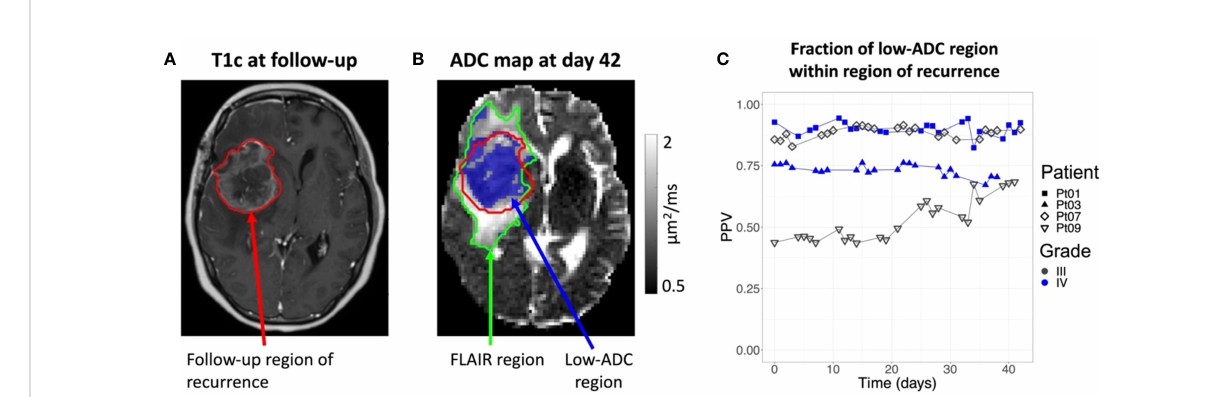
FIGURE 4 Overlap between intra-treatment low-ADC regions and recurrent tumor: (A) : The post-contrast T 1 -weighted image (T1c) of Patient 1 from a diagnostic scanner with the region of recurrence indicated by the red contour. Note that the recurrence region was taken as the enhancing tumor for the Grade 4 patients and the FLAIR hyperintensity for the Grade 3 patients. (B) : The ADC map from the MR-Linac for Day 42 from fi rst fraction of radiotherapy, corresponding to the last day of radiation for Patient 1, with the future recurrence region (red contour), FLAIR region (green contour), and low-ADC region (blue colorwash). The low-ADC region is mostly contained in the recurrence region. (C) : The positive predictive value (PPV) over time for the voxel-wise prediction of the recurrence region by the low-ADC region. By the end of treatment, most of the low-ADC region is contained within the recurrence region for all